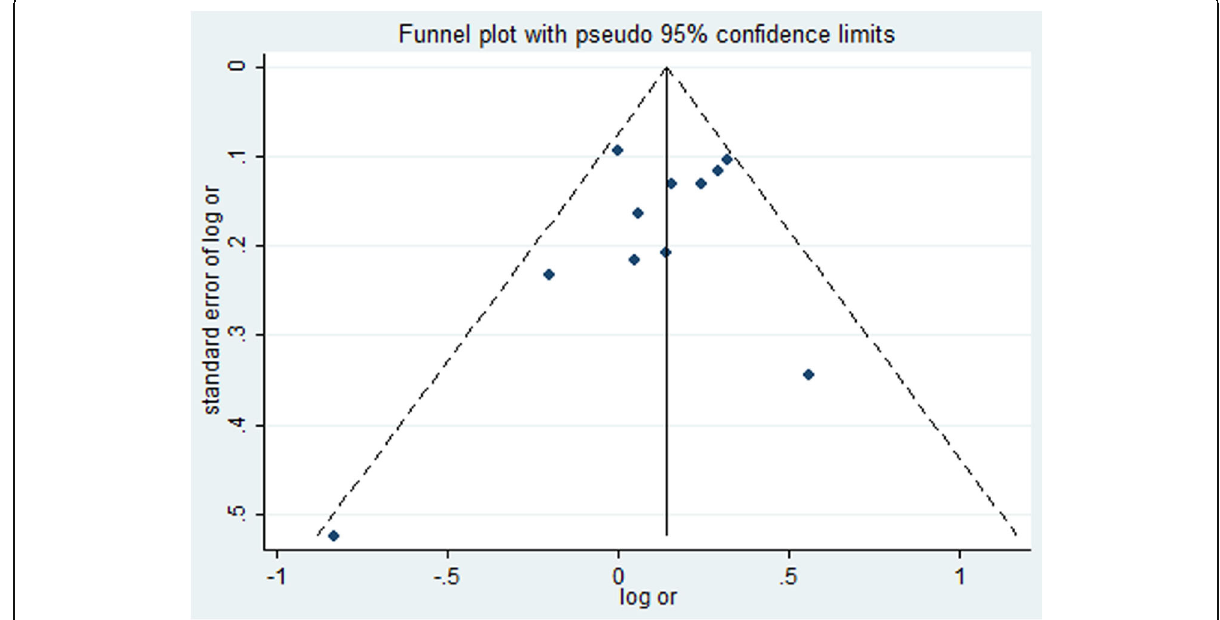
Fig. 2 Funnel plot for evaluation of publication bias in breast cancer